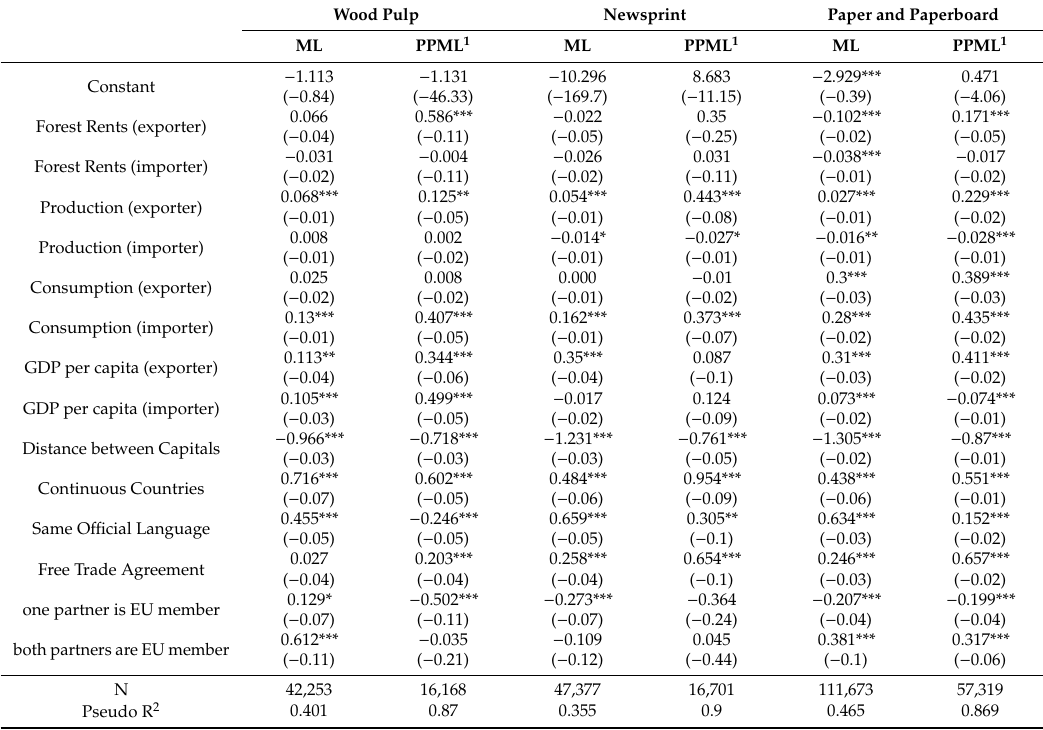
Table A5. Estimation results for the product group ‘wood pulp, newsprint and paper and paperboard’. Wood Pulp